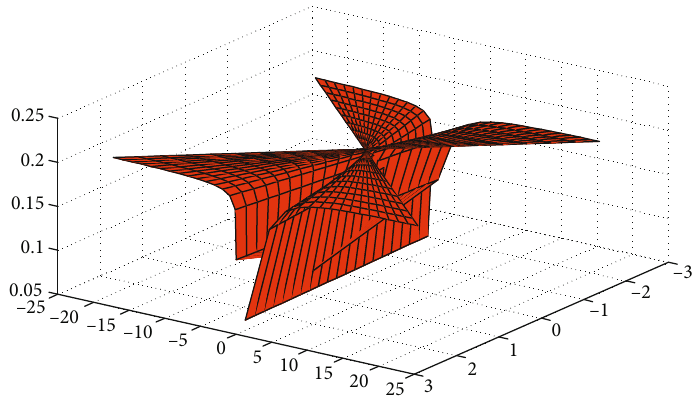
Figure 3: The NB-Smarandache ruled surface (Equation